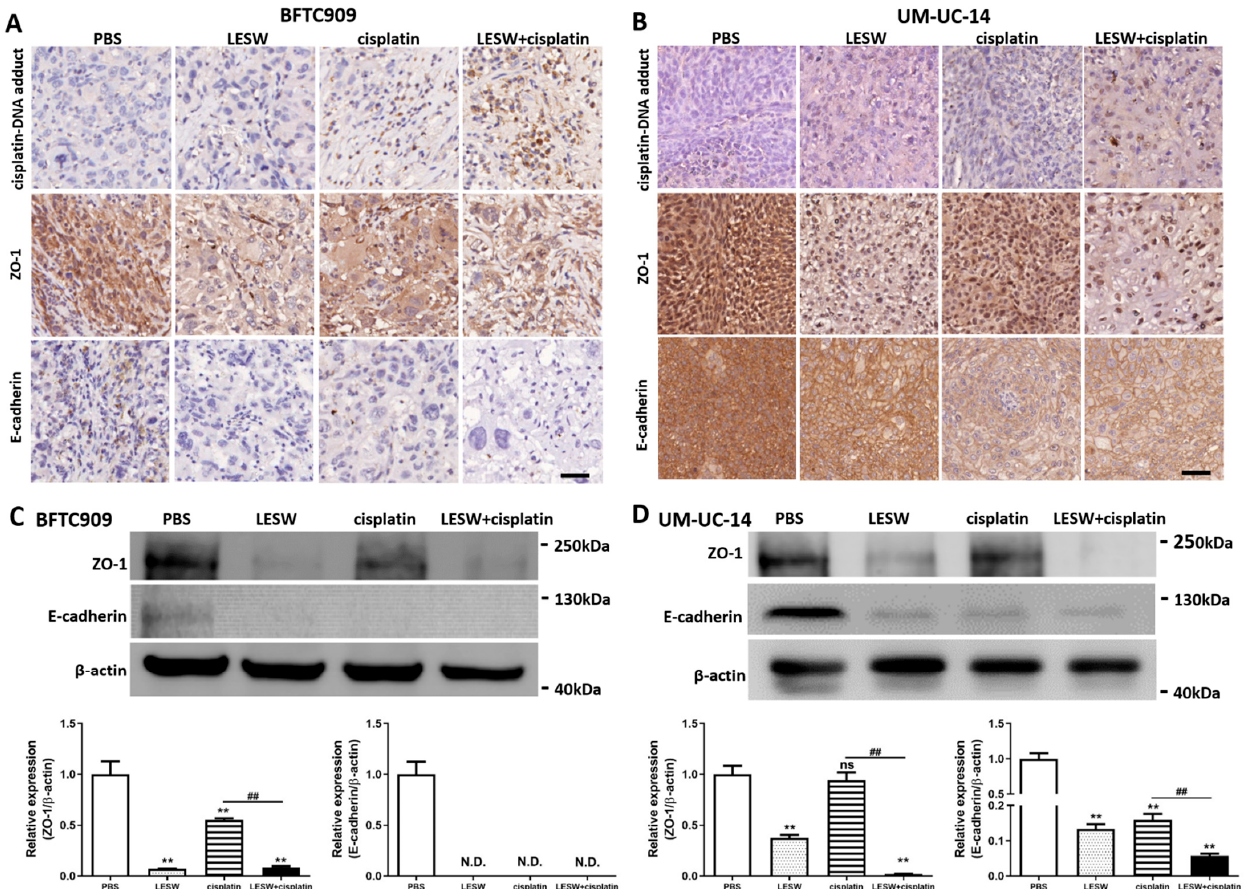
Figure 4. LESW suppressed E-cadherin and ZO-1 expression to increase cisplatin delivery in vivo. Immunohistochemical analysis of BFTC909 ( A ) and UM-UC-14 ( B ) xenograft tumour tissue sections immunolabeled for cisplatin–DNA adduct (top), ZO-1 (middle) and E-cadherin (bottom). Scale bars indicate 40 µ m. The lysates from BFTC909 ( C ) and UM-UC-14 ( D ) xenograft tumour were analysed by Western blotting with the indicated antibodies. Error bars represent mean ± S.E.M., N.D.: not detected, the p values were calculated with one-way ANOVA followed by Tukey’s multiple-comparison test, ** p < 0.01 versus control group, ns indicates no significance between the control group and CDDP group, ## p < 0.01 versus CDDP group. Full Western blot images can be found in Figure